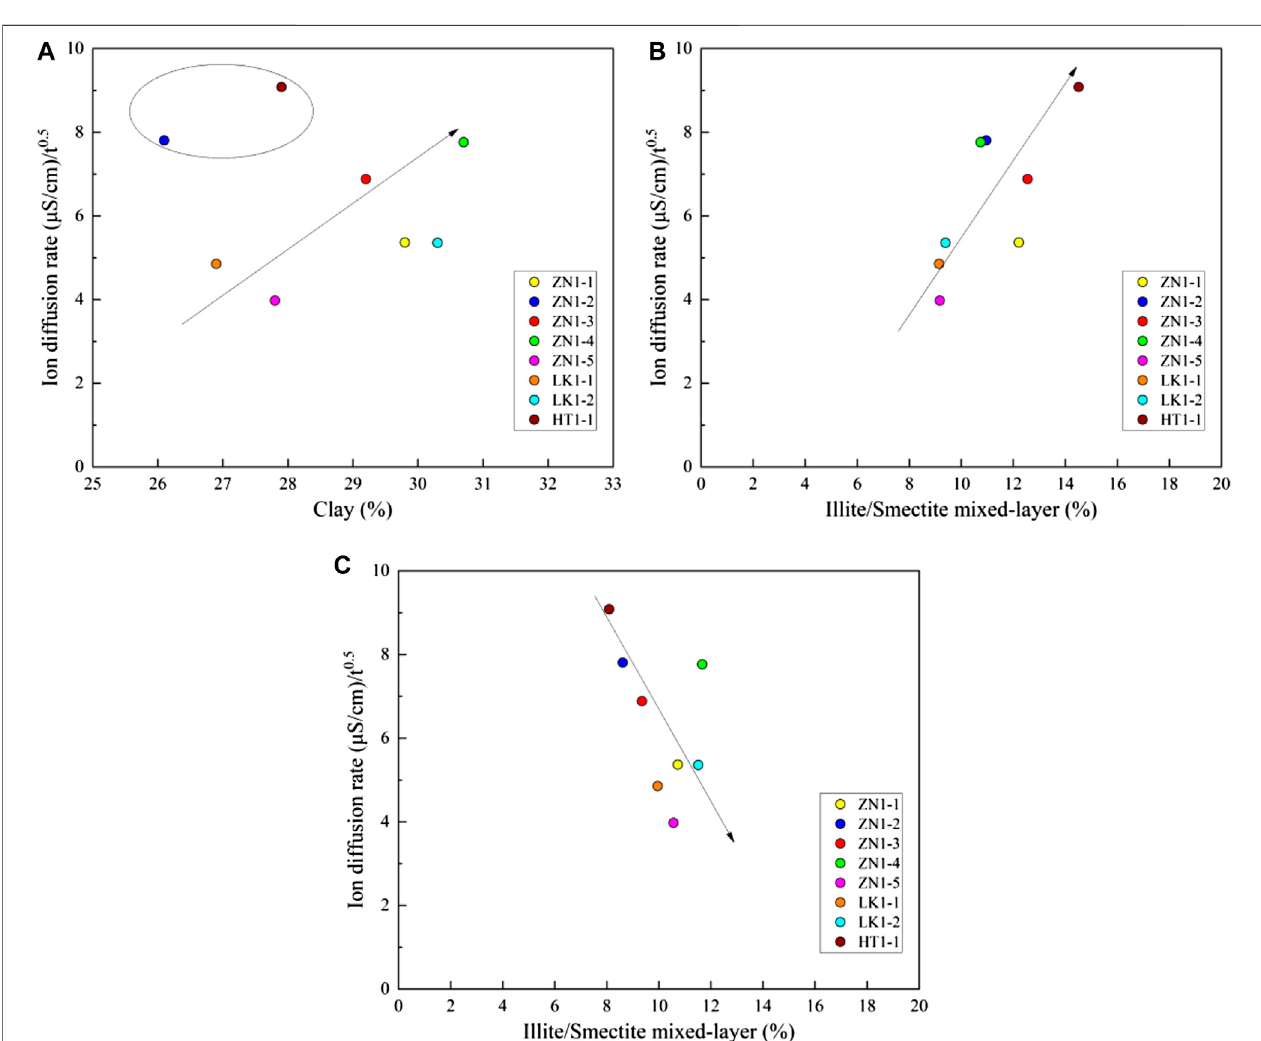
FIGURE 12 | The effects of clay minerals on ions diffusion rate (A) the total clay minerals, (B) the I/S minerals and (C) the illite minerals.